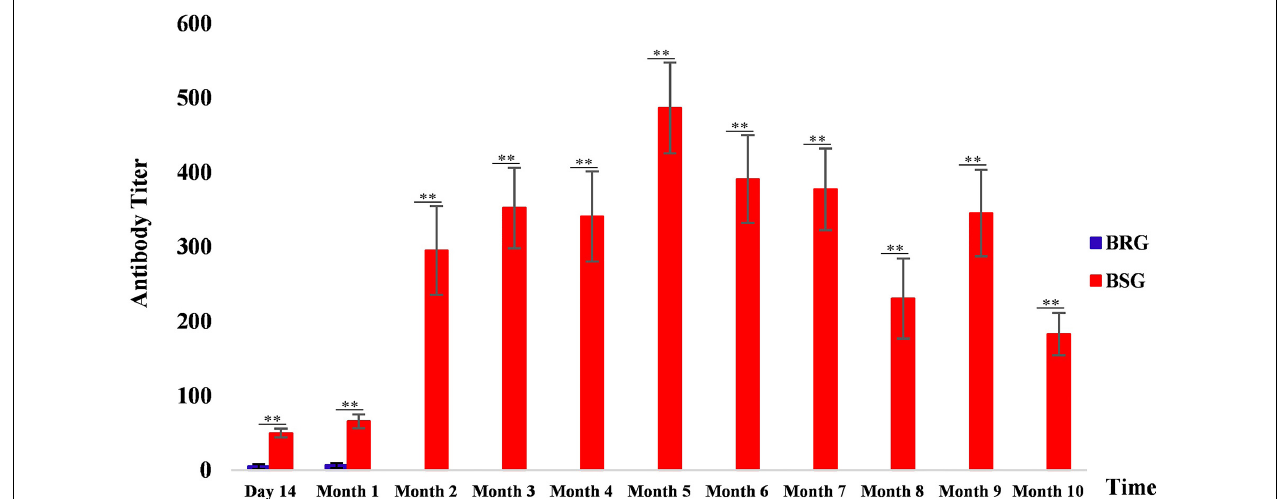
FIGURE 1 | Brucella antibody levels in sheep from the brucellosis-resistant group (BRG) and brucellosis-susceptible group (BSG). Blue and red represent the antibody levels of BRG and BSG, respectively, ∗∗ highly significant difference (Mann–Whitney U test, p < 0.01).